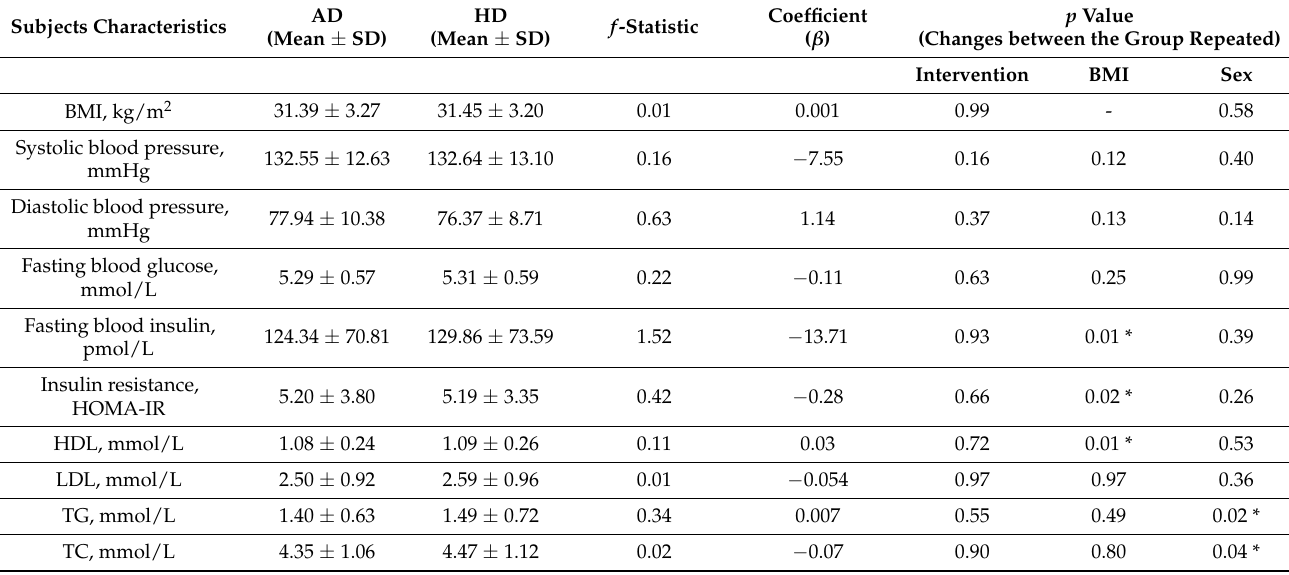
Table 1. Coefficient estimates from GLMM analyses for main characteristic of subjects at the end of each phase following adequate dairy product intake (AD) and high dairy product intake